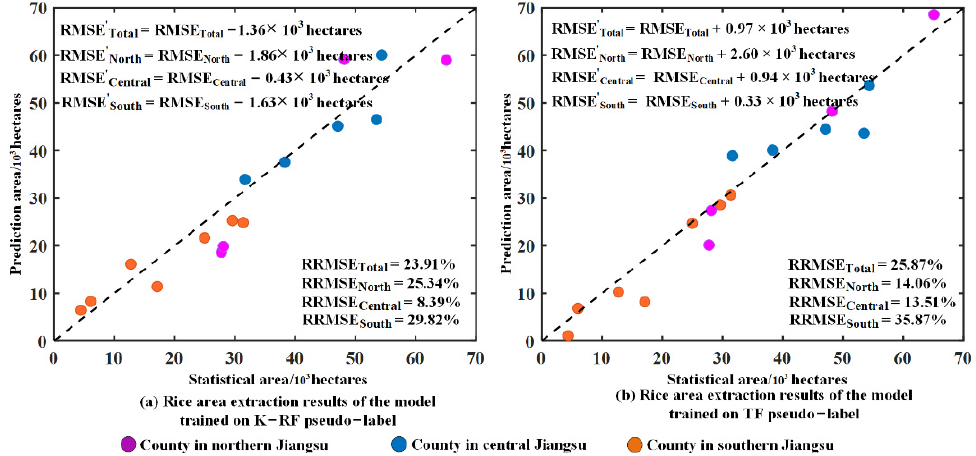
Figure 10. The comparison of rice areas between the statistics data and the extraction results of the